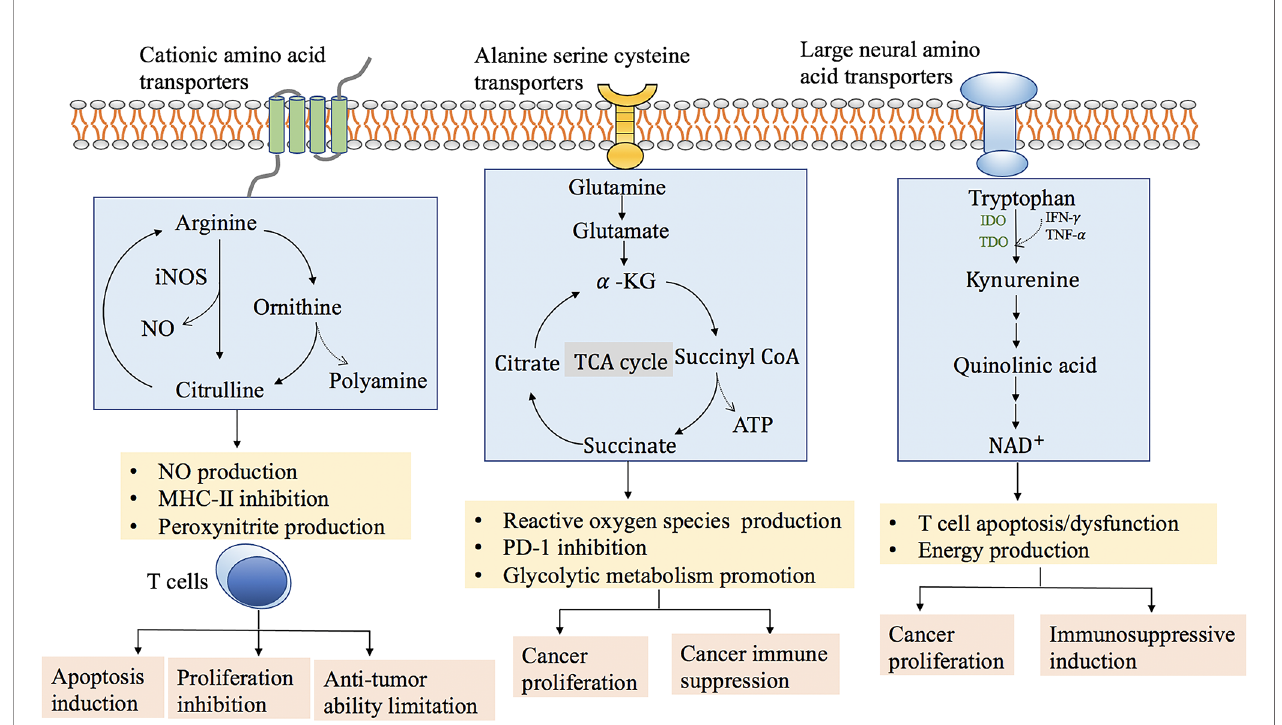
FIGURE 1 | The role of amino acids, arginine, glutamine and tryptophan metabolism in cancer progression and immune